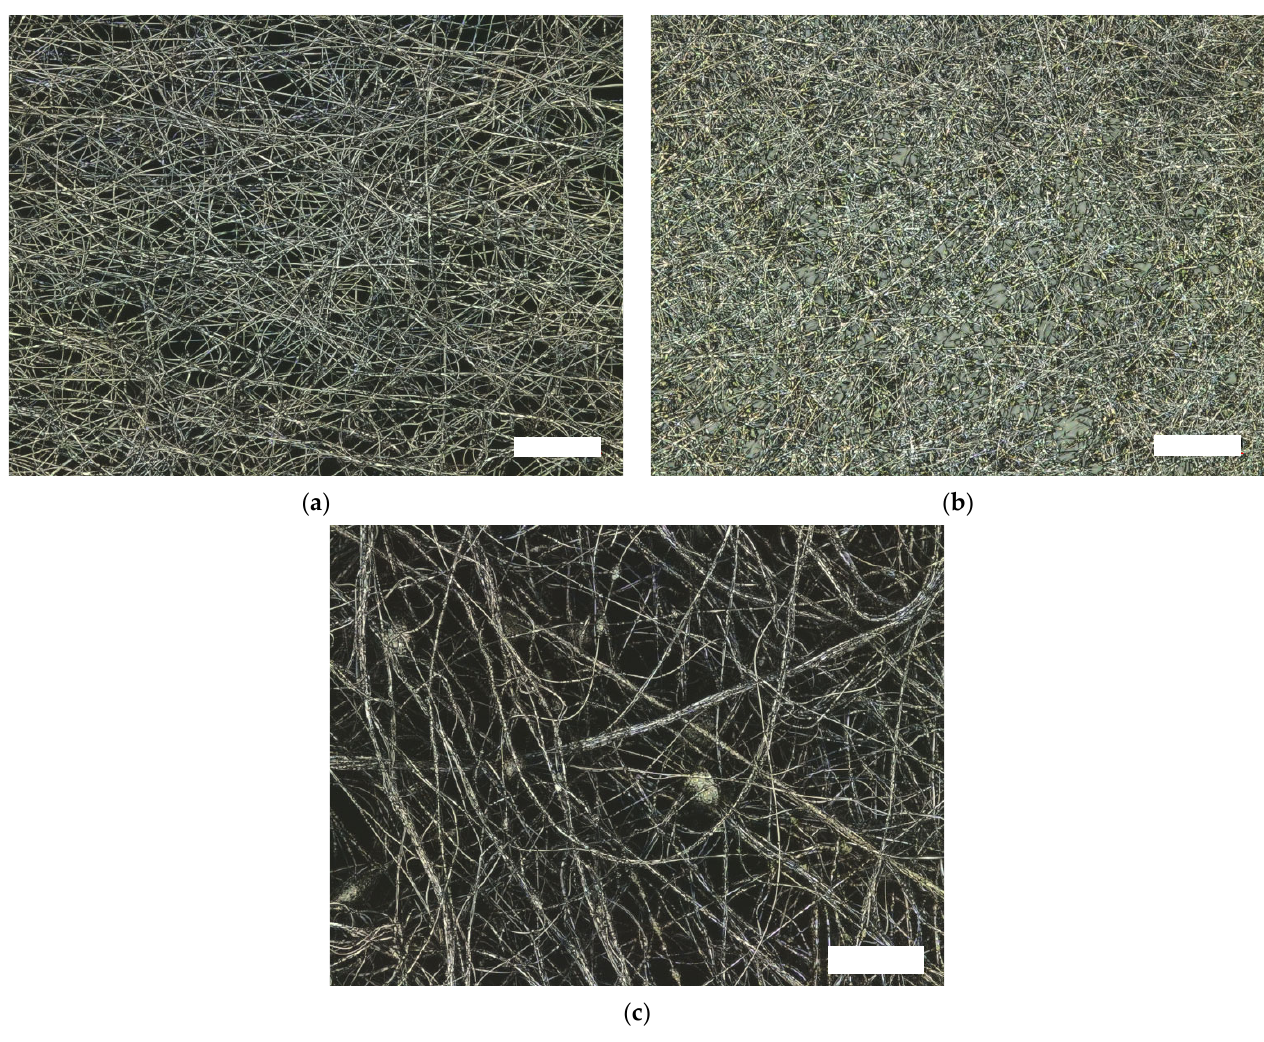
Figure 4. Confocal laser scanning microscope (CLSM) images of the magnetic nanofiber mats: ( a ) 18 wt% PAN with 65 kV voltage and 40 min ultrasonic bath; ( b ) 18 wt% PAN with 80 kV voltage and 40 min ultrasonic bath; ( c ) 18 wt% PAN and 80 kV voltage without ultrasonic bath. Scale bars indicate 20 μ m.